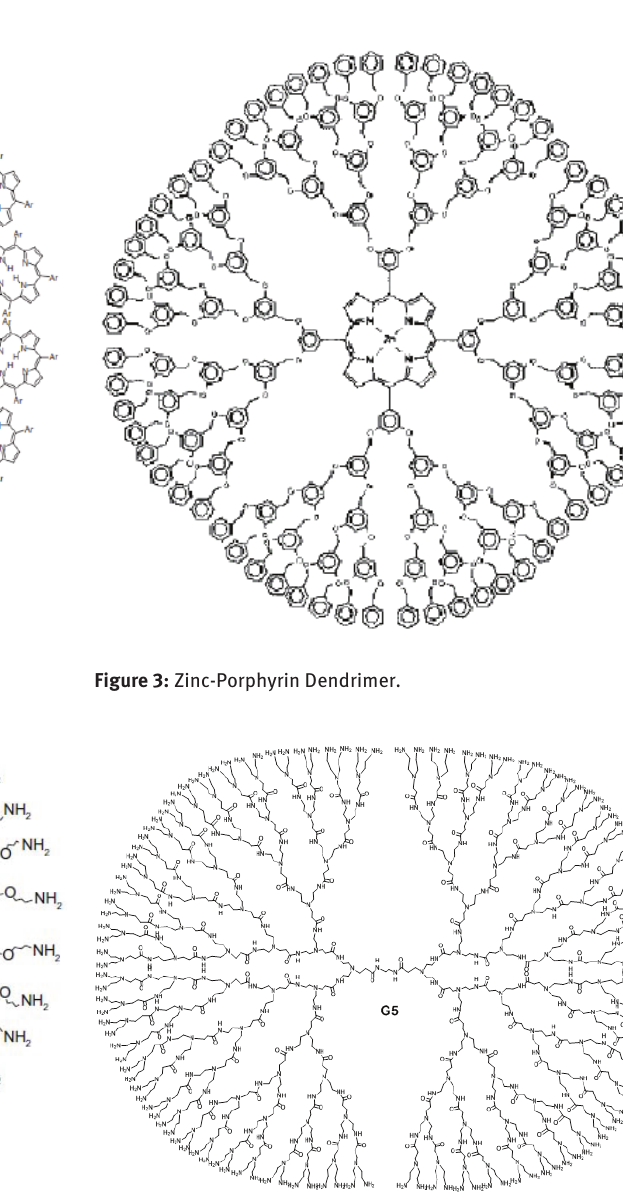
Figure 2: Propyl Ether Imine Dendrimer.